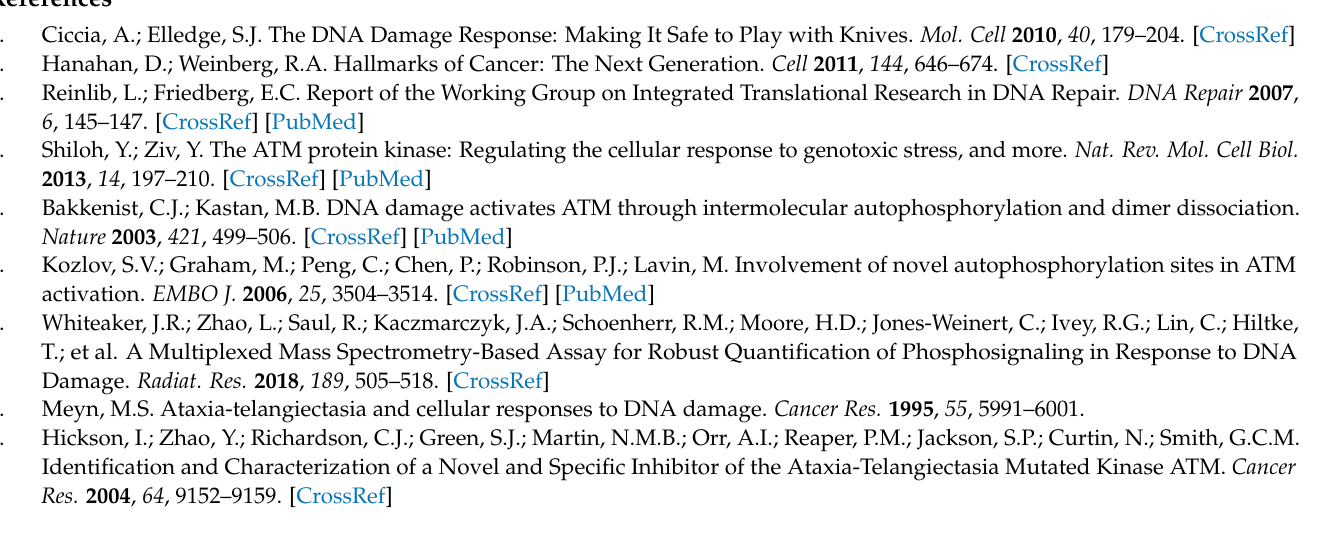
Table S2: Antibody characterization data for immunoassay applications, Table S3: Fit-for-purpose bioanalytical validation of the immuno-MRM assay, Table S4: Immuno-MRM results for LCL ex- periments, Table S5: Immuno-MRM results for PBMC experiments, PDF Document S1: Results for extensive antibody